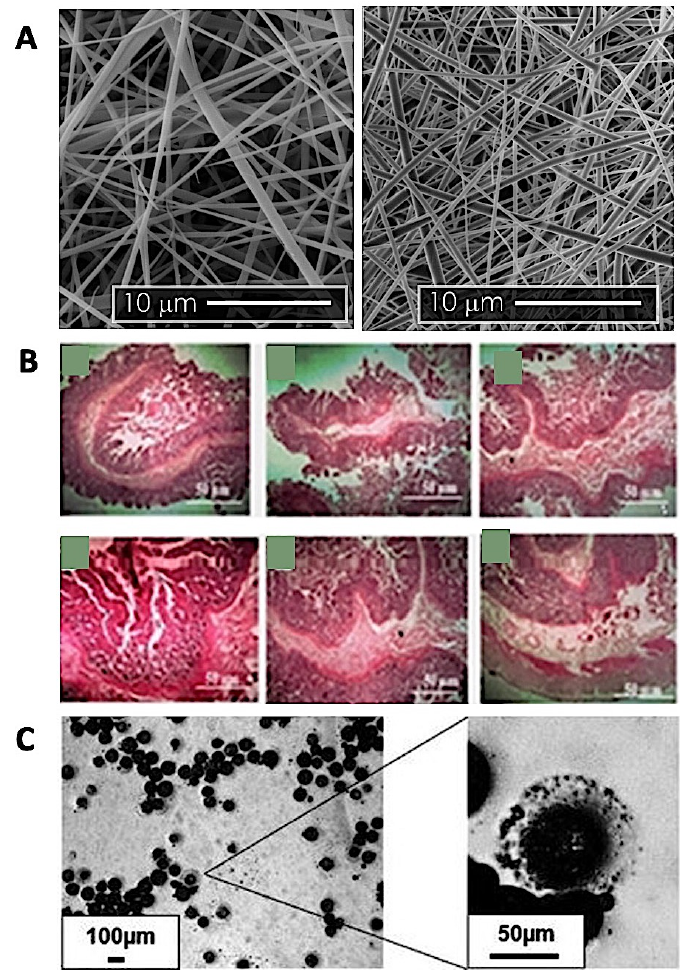
Figure 5. ( A ) Scanning electron microscope (SEM) images of cyclodextrin-antibiotic nanofibers [183]. Reprinted with permission from ref. [183]. Copyright 2020 Elsevier Inc. ( B ) Microscopic images of tissue histology after treatment with a self-emulsifying drug delivery system (SEDDS) in the intestine [184]. Reprinted with permission from ref. [184]. Copyright 2021 Elsevier Inc. ( C ) SEM images of encapsulated phage [185]. Reprinted with permission from Kerry and Danish (2021). Copyright 2021 Kerry and Danish.